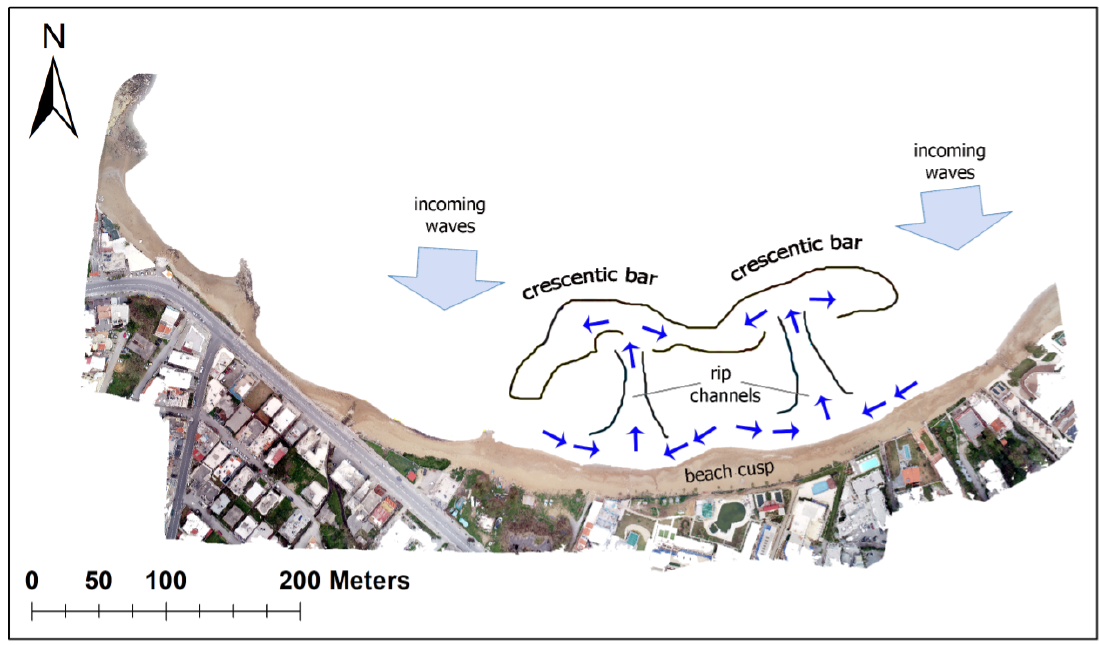
Figure 7. Conceptual model about coastal circulation and corresponding geomorphology features occurring at the study area. This model resulted from an adaptation of the bathymetric difference map (Figure 5). The thin blue arrows indicate the direction of nearshore currents.